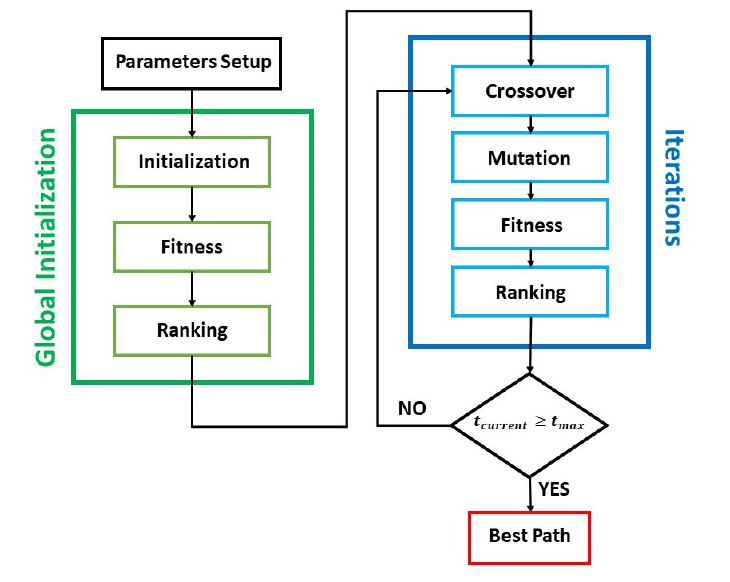
Figure 2. Flowchart of the Genetic Path